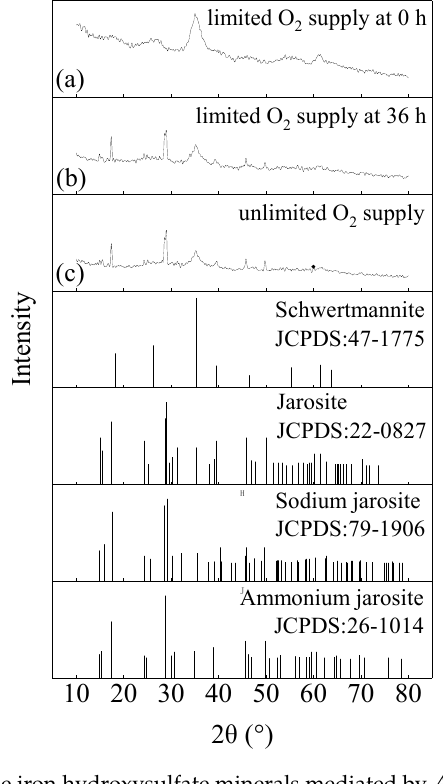
Figure 6. XRD patterns of the iron hydroxysulfate minerals mediated by A. ferrooxidans under different O 2 supply times, i.e., ( a ) limited O 2 supply at 0 h; ( b ) limited O 2 supply at 36 h and ( c ) unlimited O 2 supply.